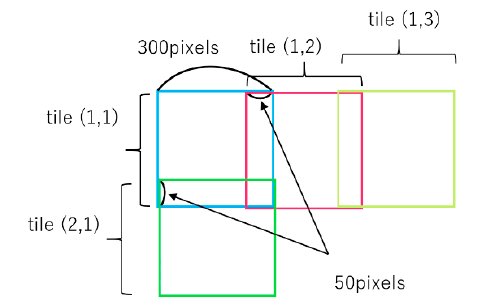
Figure 6. Detection procedure for an image larger than 300 × 300 pixels. The image is separated into 300 × 300 pixel tiles with an overlap of 50 pixels, and the detection results of each tile are merged.